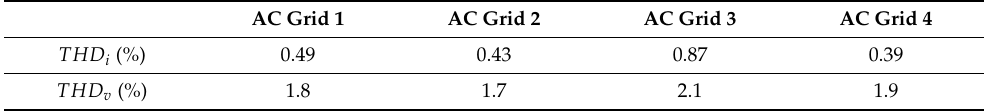
Table 4. Total harmonic distortion for the grid current and the voltage at the